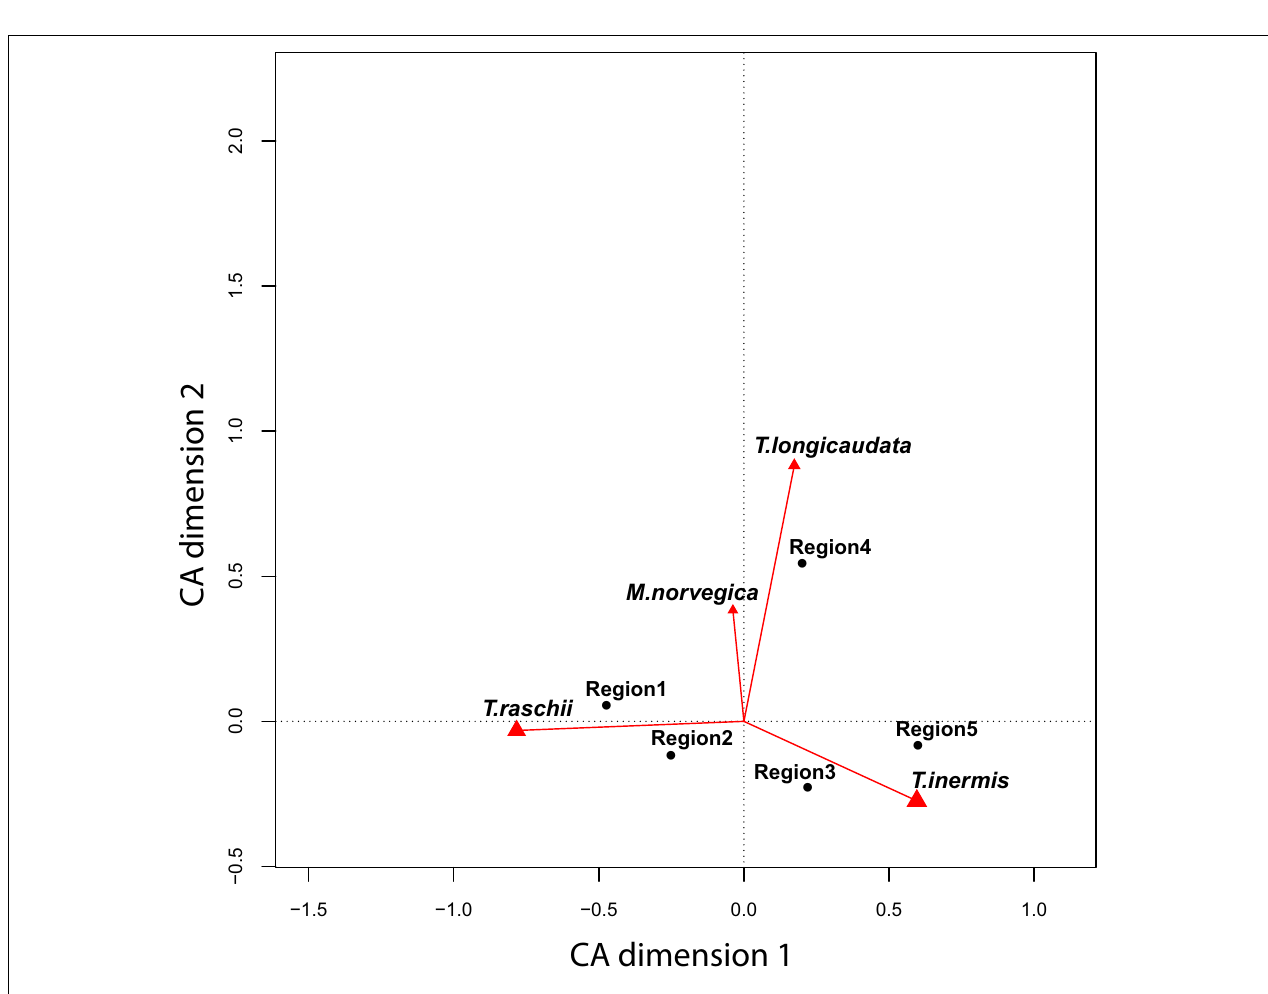
FIGURE 3 | Correspondence Analysis (CA) biplot for all stations and years. The two axes explain more than 99% of the total variability among regions. Black points represent the center of mass for each region, and the vectors indicate the strength (length) and direction of positive loadings of these species (T., Thysanoessa ; M, Meganyctiphanes ). The horizontal axis is